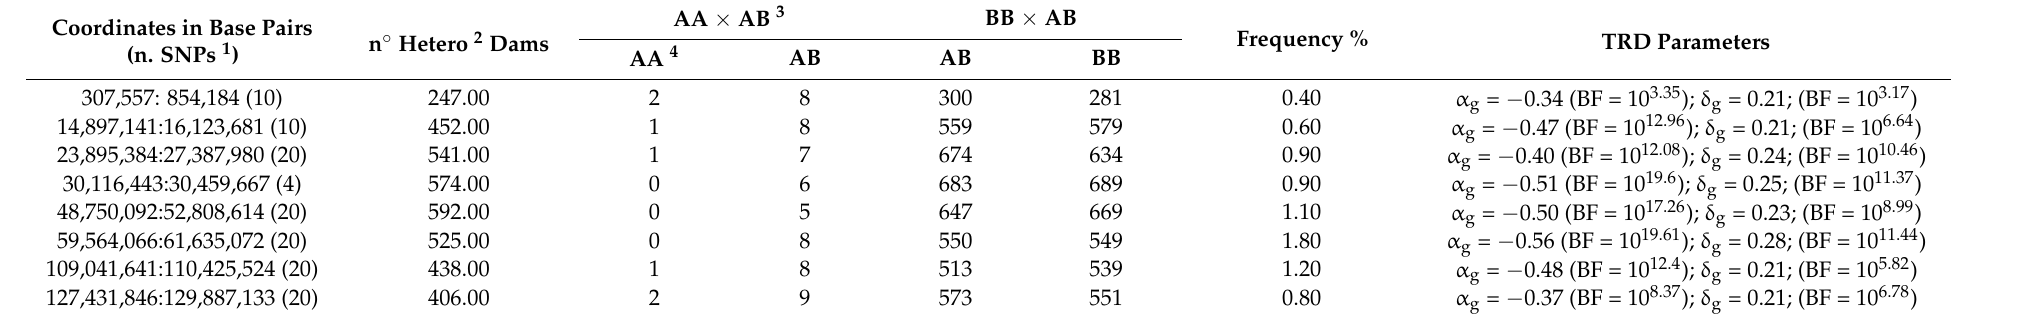
Table 4. Haplotype windows with recessive TRD pattern on heterosomal part of Holstein X-chromosome. Coordinates in Base